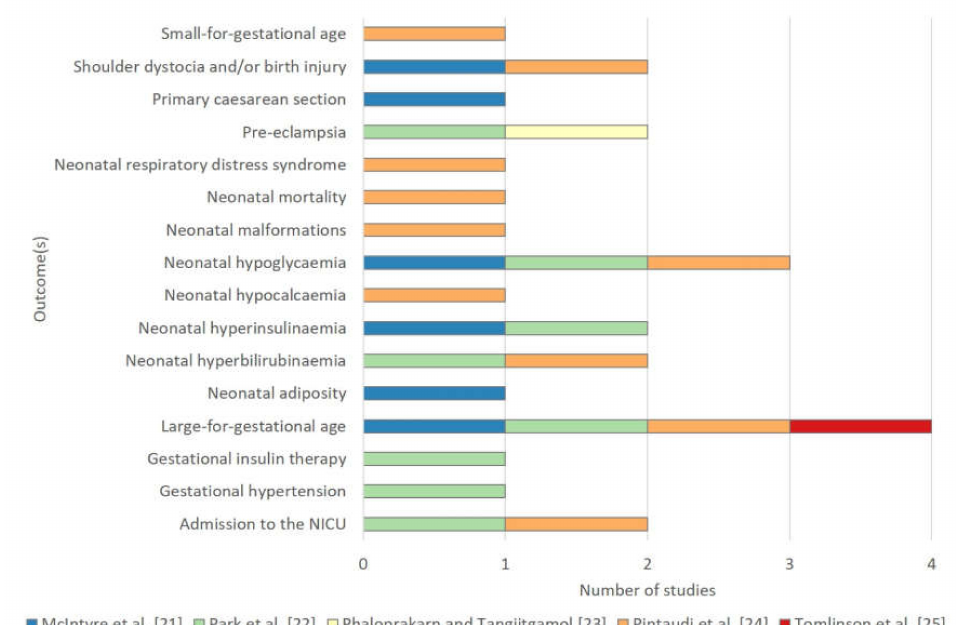
Figure 2. Outcome(s) to be predicted by studies for pregnancy complications in women with gestational